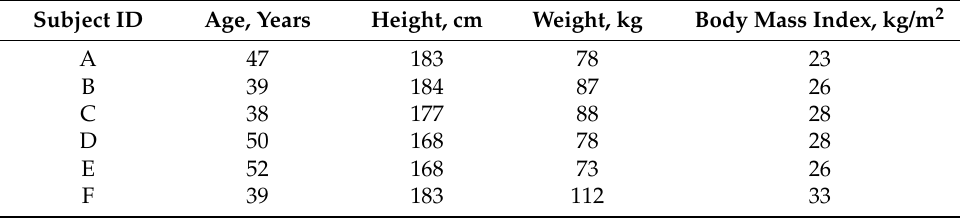
Table 1. Characteristics of subjects participating in the